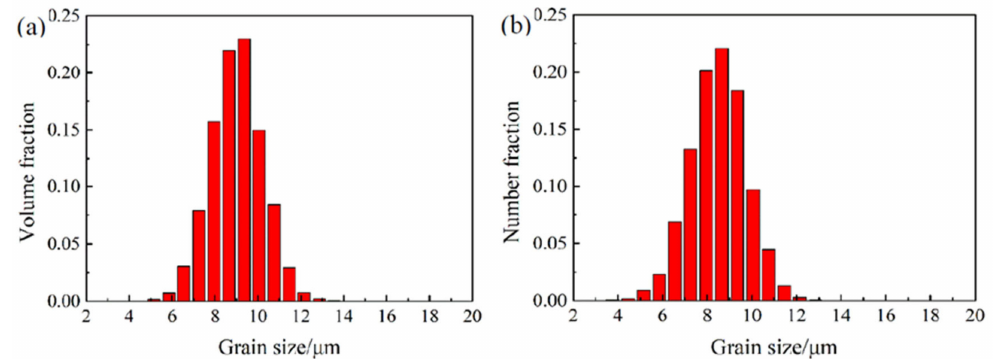
Figure 2. Grain size distribution of a random 3D polycrystal in a representative volume elements (RVE) of 150 × 150 × 150 voxels for 10,000 grains: ( a ) volume fraction and ( b ) number